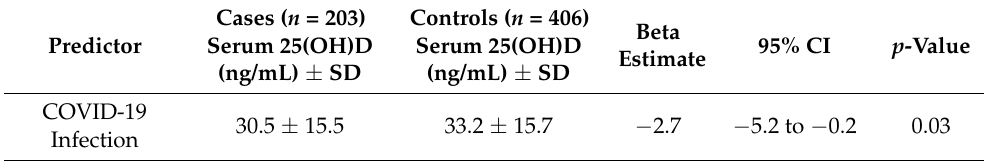
Table 4. Post-diagnosis—ordinary least squares